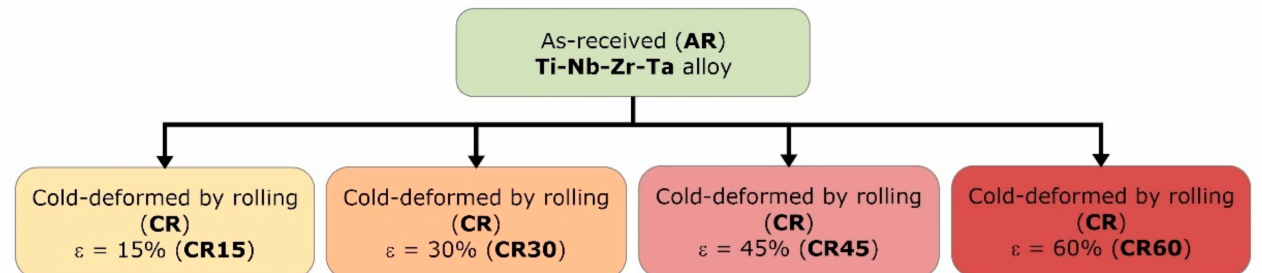
Figure 1. Processing scheme applied to Ti-32.9Nb-4.2Zr-7.5Ta (wt.%)